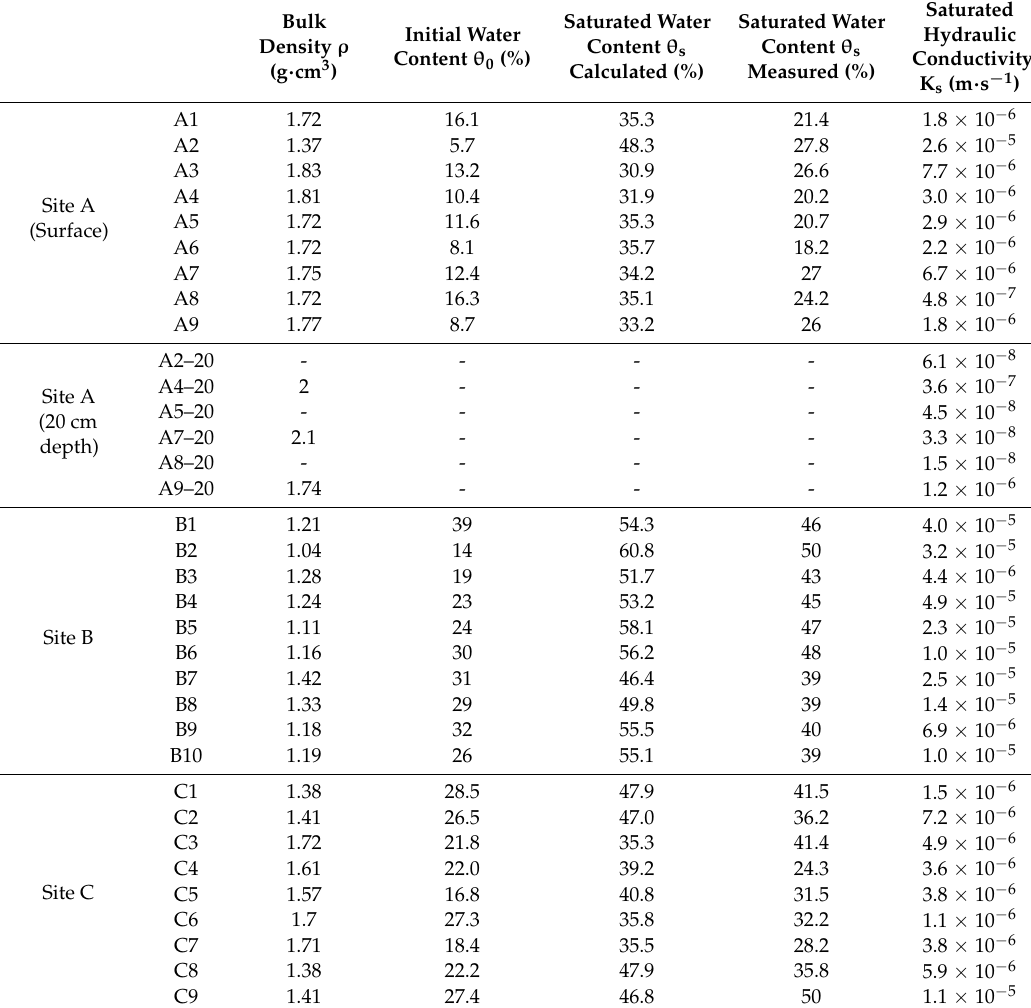
Table A1. Soil hydraulic properties at each measurement point and for the four sites A, B, C and